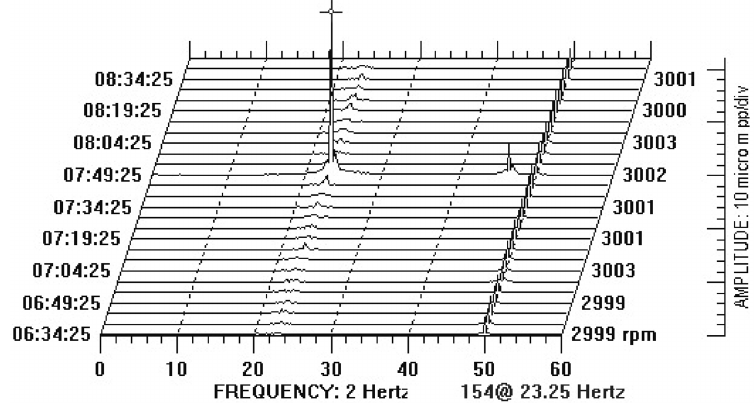
Fig. 10. Waterfall plot of the vibrations measured on the support #2 (direction Y) during the occurrence of abnormal vibration